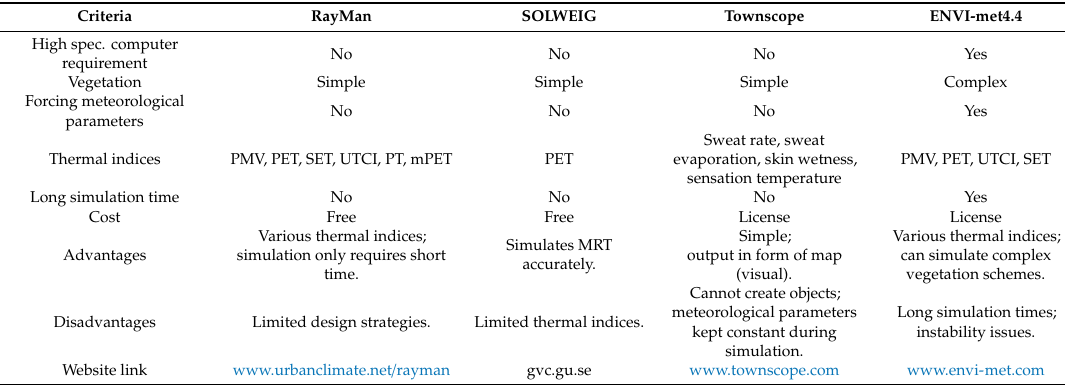
Table 2. Comparison of the common microclimate modelling